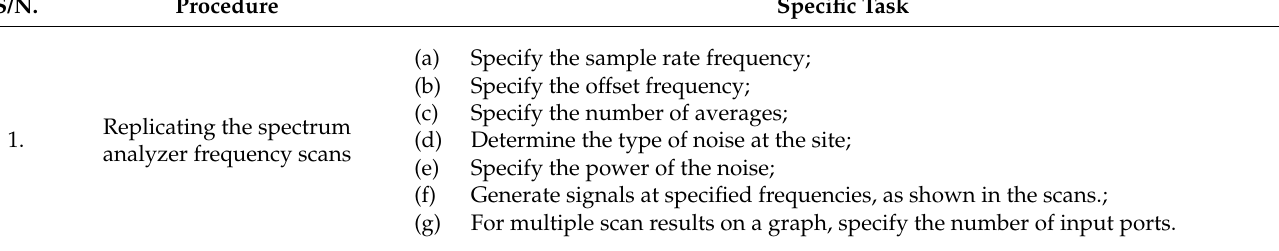
Table 4. Step-by-step procedure for measured data processing and analysis.